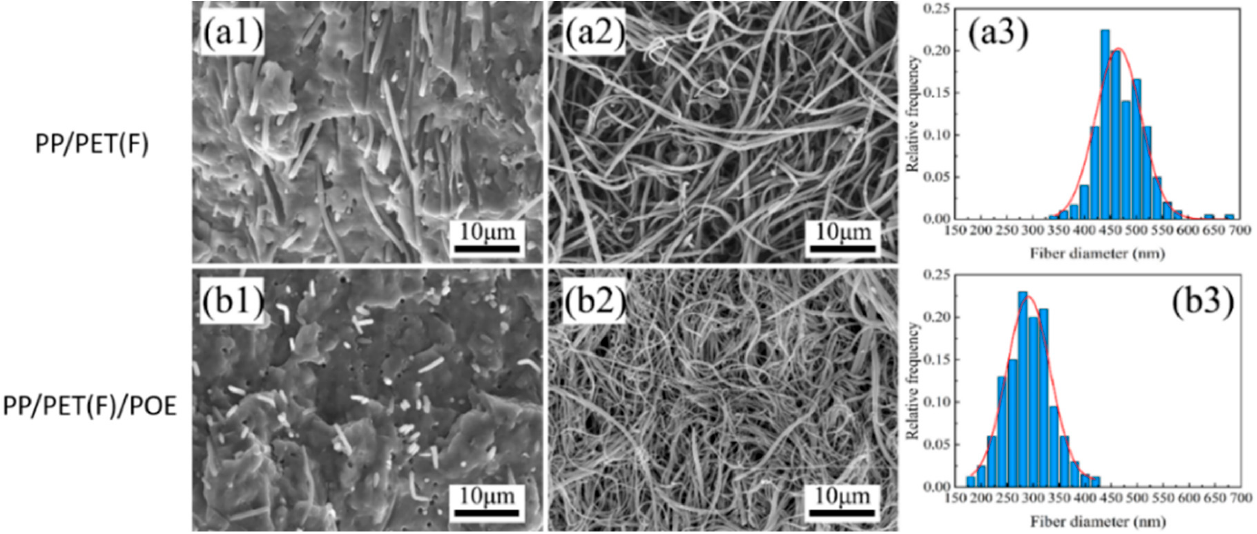
Figure 5. SEM images of fibrillary PP based composite before ( a1 , b1 ) and after etching PP matrix ( a2 , b2 ) with xylene vapor and size distribution of PET fibrils ( a3 , b3 ).